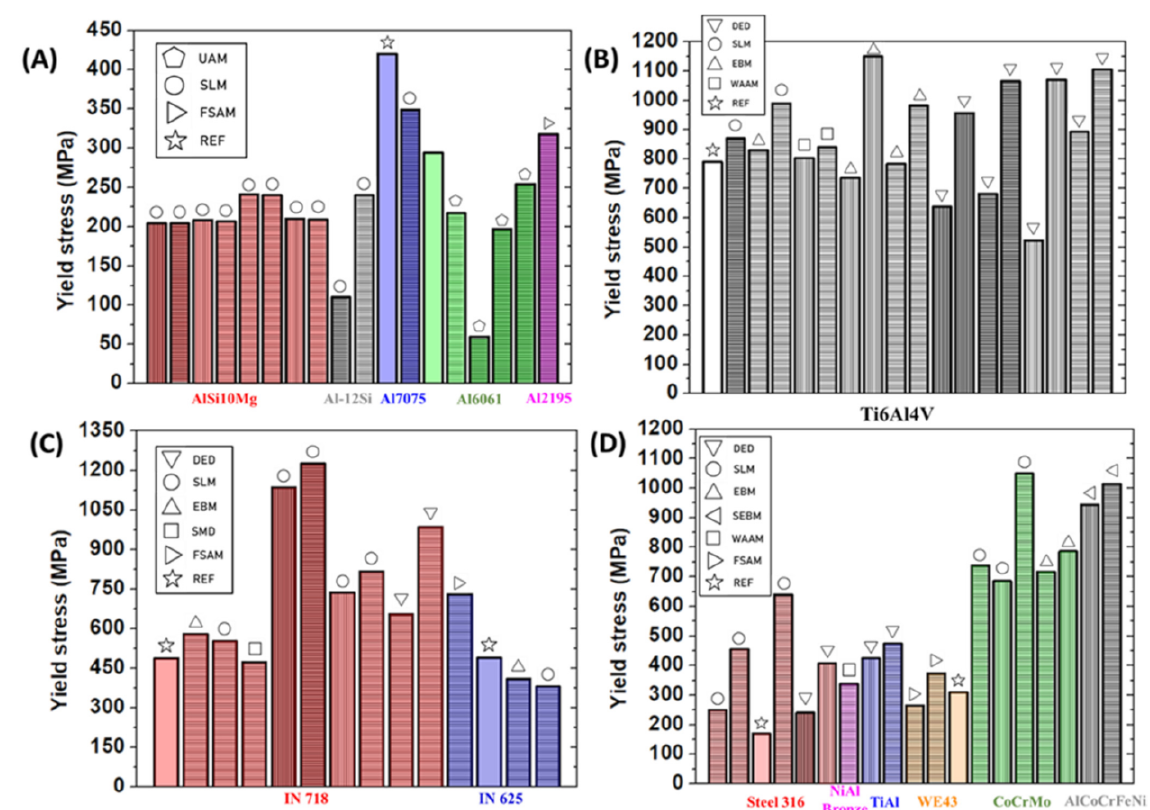
Figure 27. ( A ) Selected values of the yield stress of aluminum-based alloys from existing literature on metal AM. The horizontally patterned bar indicates horizontally printed samples, and the vertically patterned bar indicates vertically printed samples. [118–121,152,160–163] ( B ) Selected values of the yield stress of Ti6Al4V alloys from existing literature on metal AM [122–127,140–145]. ( C ) Selected values of the yield stress of nickel-based alloys from existing literature on metal AM [83,128,139,147,156–159,164]. ( D ) Selected values of the yield stress of other alloys besides aluminum-based, nickel- based, or Ti6Al4V alloys from existing literature on metal AM [138,146,148–154,165–168]. The bolded pattern indicates a heat-treated